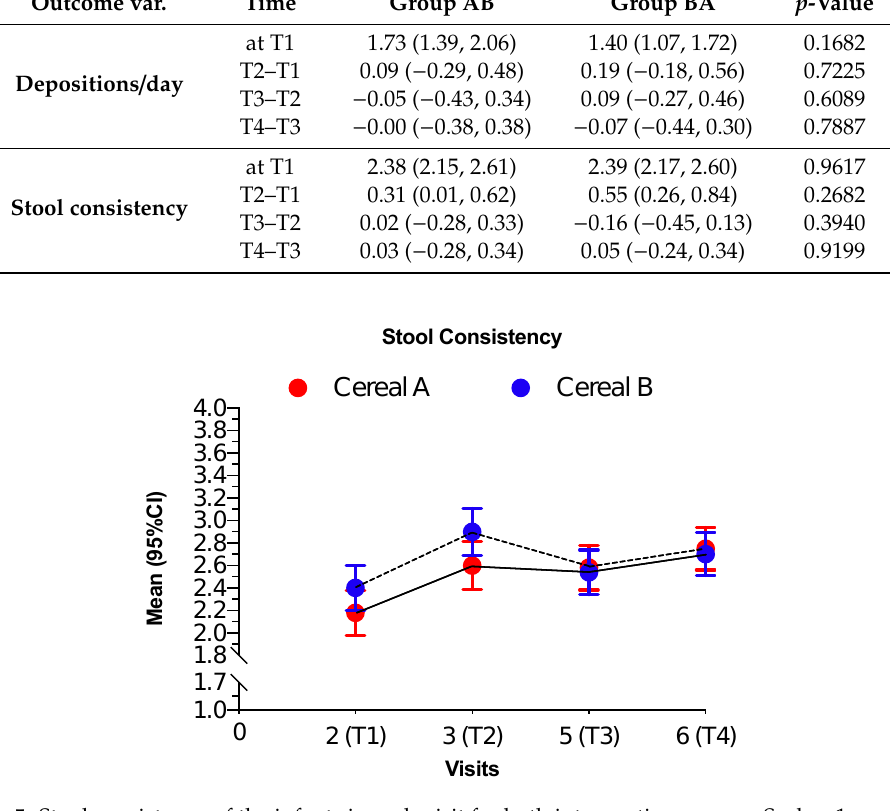
Figure 5. Stool consistency of the infants in each visit for both intervention groups. Scale—1 = watery, 2 = soft, 3 = formed, 4 = hard. Values are shown as mean and 95% confidence intervals. Continuous line represents the intervention group AB and the discontinuous line represents the intervention group BA. Cereal A—0% whole grain and 24 g / 100 g sugar; Cereal B—50% whole grain and 12 g / 100 g